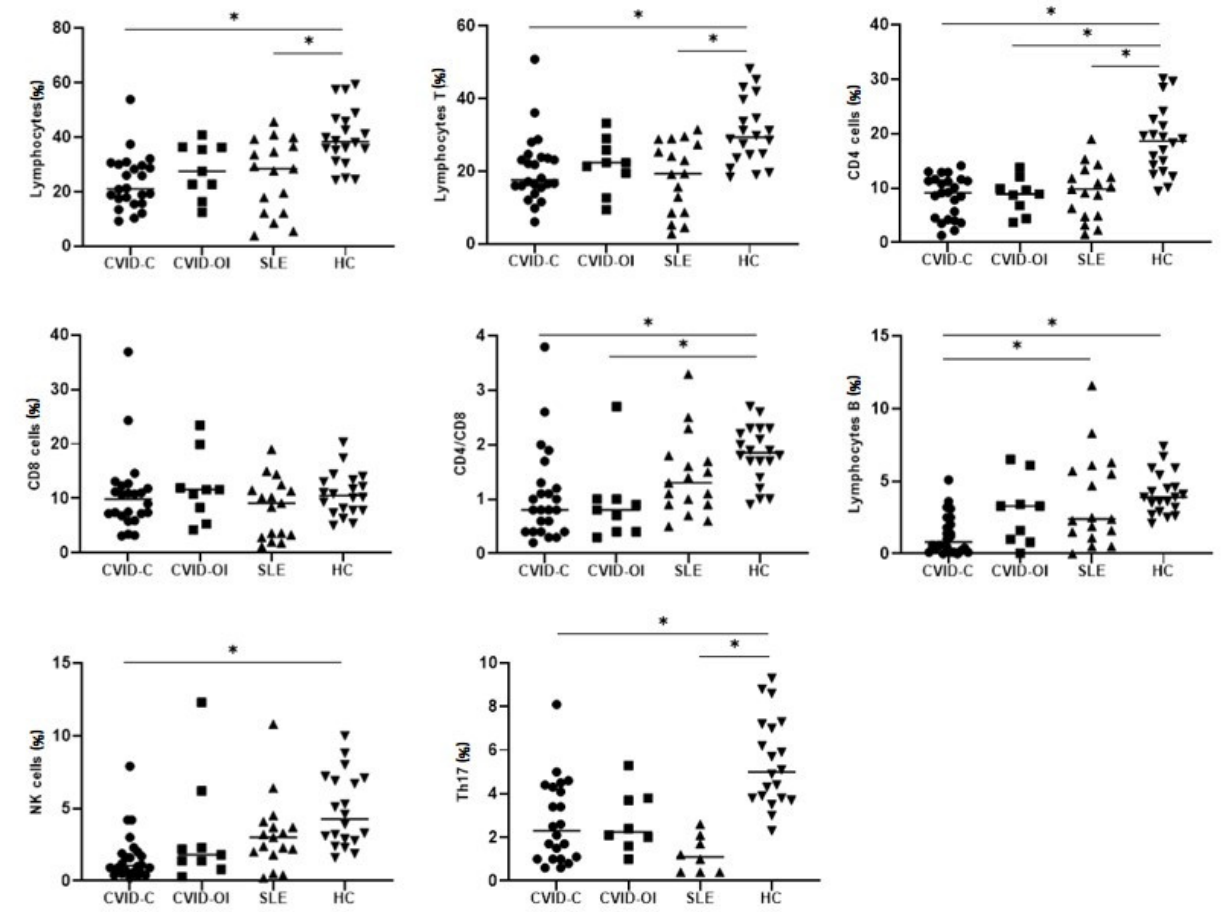
Figure 1. Differences in the median percentages of lymphocyte subpopulations between the CVID with complicated phenotype (CVID-C) group, the CVID phenotype limited to only infections (CVID-OI), patients with systemic lupus erythematosus (SLE), and healthy controls (HCs). Data expressed as median (Q1–Q3), * p <